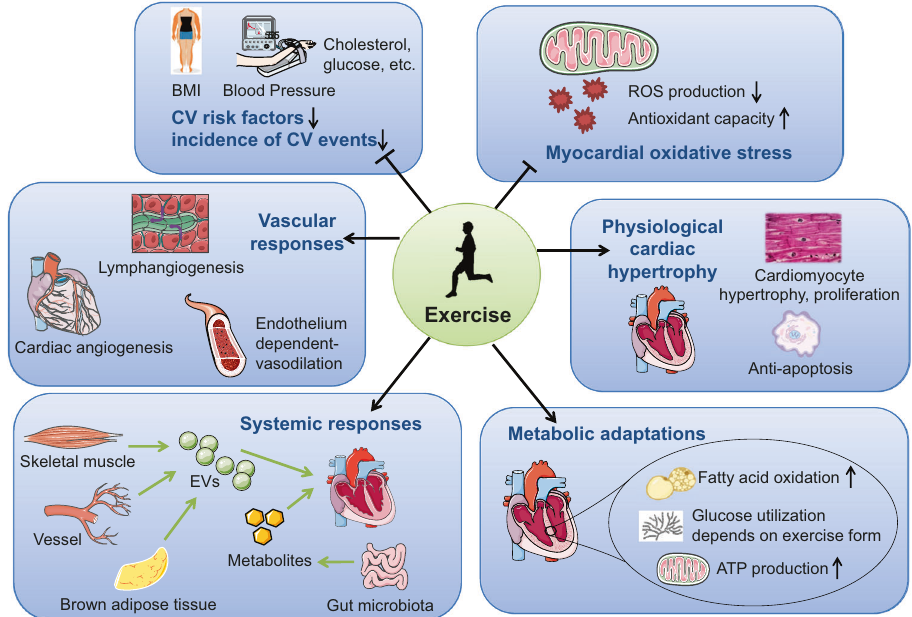
Fig. 1 Bene fi cial effects of exercise training in cardiovascular health. Exercise training can exert bene fi cial effects for cardiovascular health through multiple aspects including reducing cardiovascular risk factors and cardiovascular events, reducing myocardial oxidative stress, promoting physiological cardiac hypertrophy, inducing vascular responses, cardiac metabolic adaptations, and systemic responses. BMI body mass index, CV cardiovascular, EVs extracellular vesicles, ROS reactive oxygen